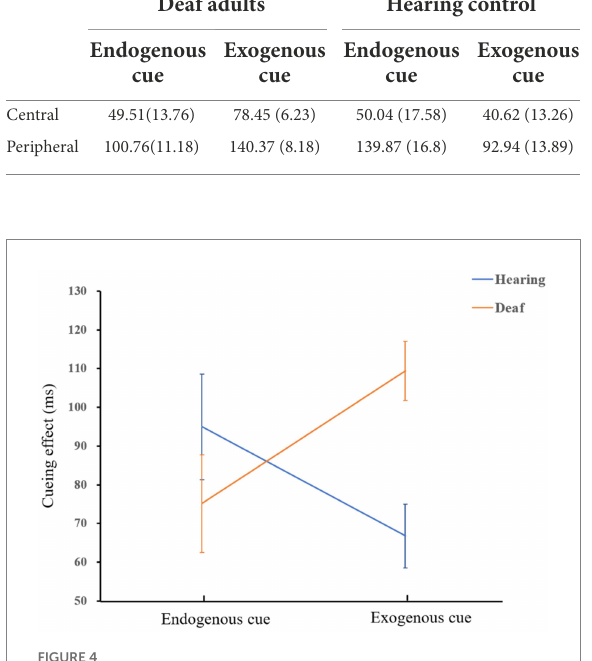
FIGURE 4 The interaction of group and cue type when there is a long